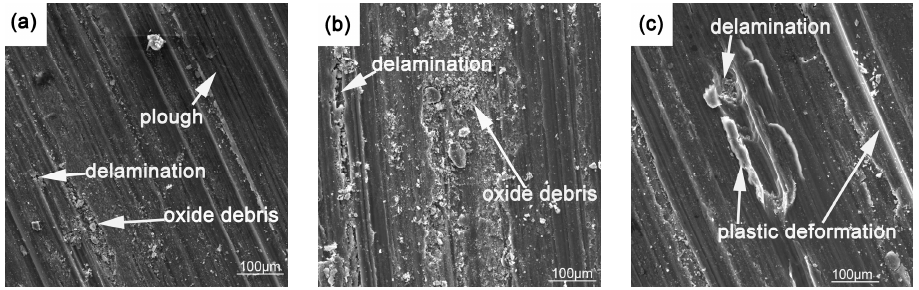
Figure 12. SEM images of worn surface for AZ91-0.5%Pr alloy under different applied loads ( a ) 30 N, ( b ) 60 N and ( c ) 90 N.